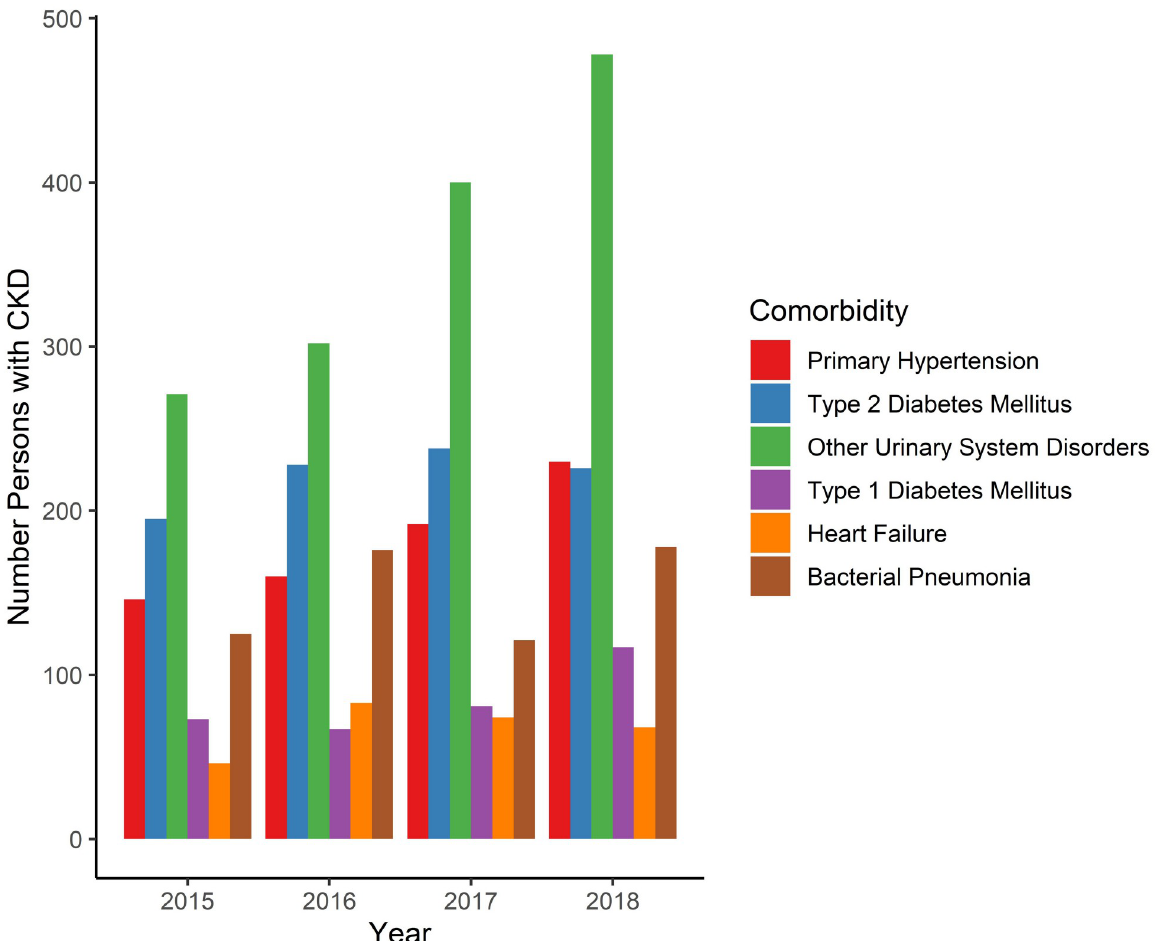
Fig 4. Comorbidities among CKD patients in IESS, 2015–2018. Annual number of hospitalized CKD patients in IESS system with comorbidities, 2015–2018. Comorbidities were determined by individual ICD-10 codes. Many patients had more than one comorbidity.